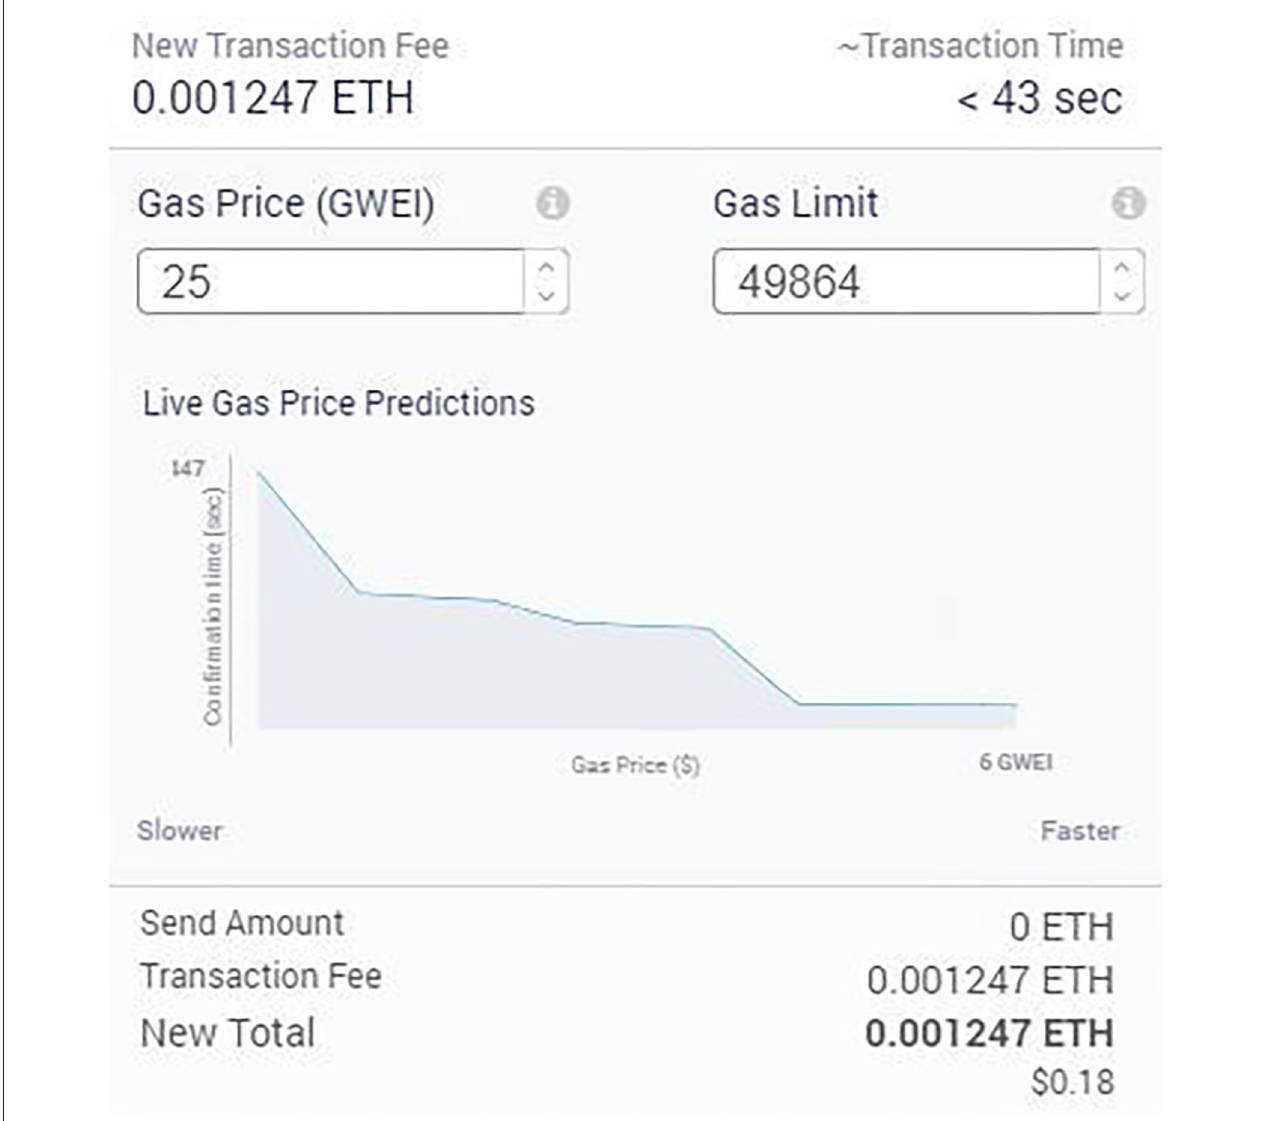
FIGURE 12 | Tx cost for executing a smart contract function.